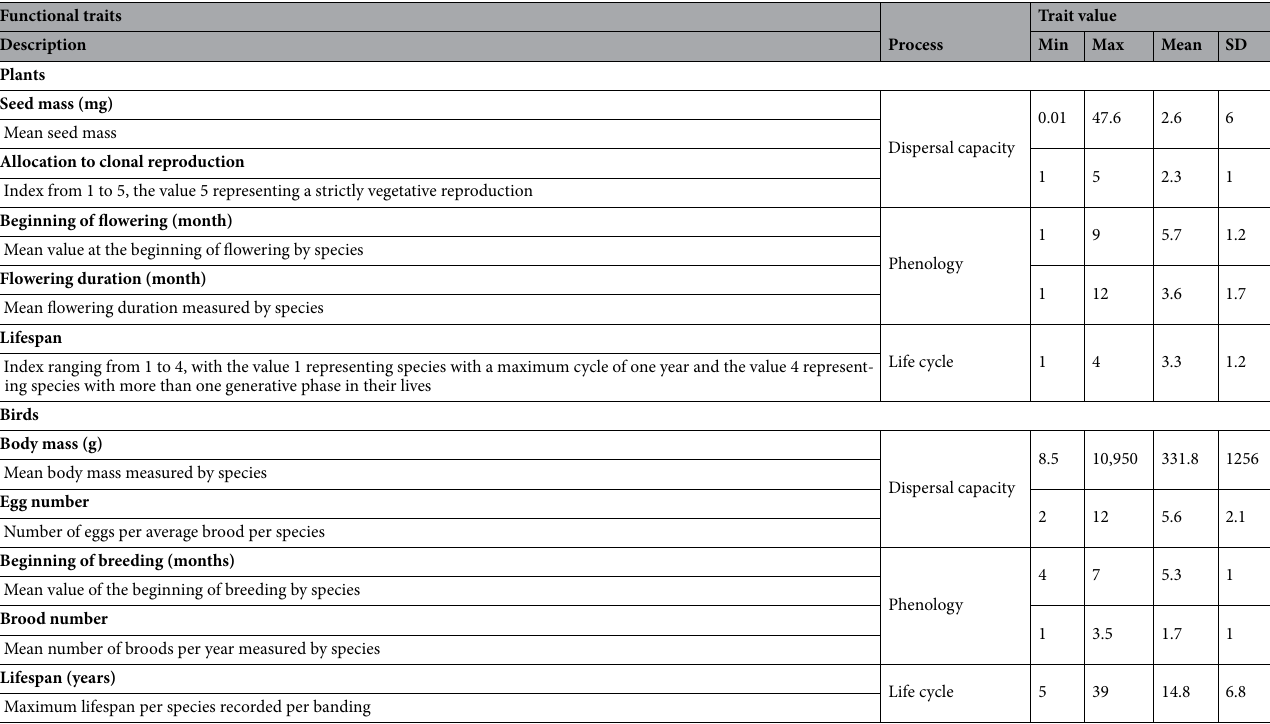
Table 1. Functional response traits selected for plants and